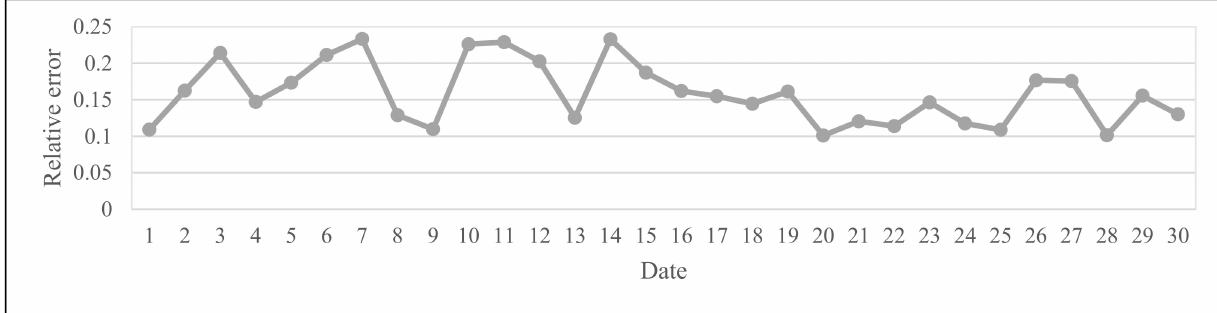
Figure 6. Relative error of cash flow forecast of G company in April